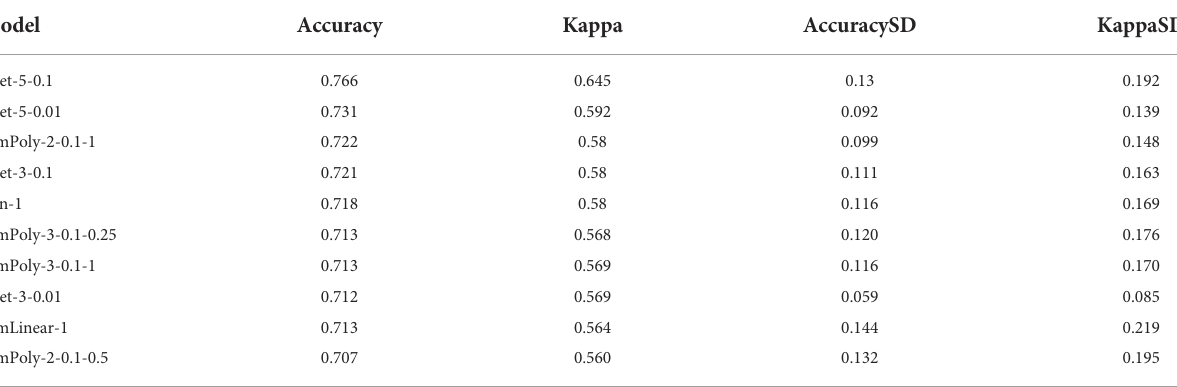
TABLE 2 The accuracy and kappa-value of top 10